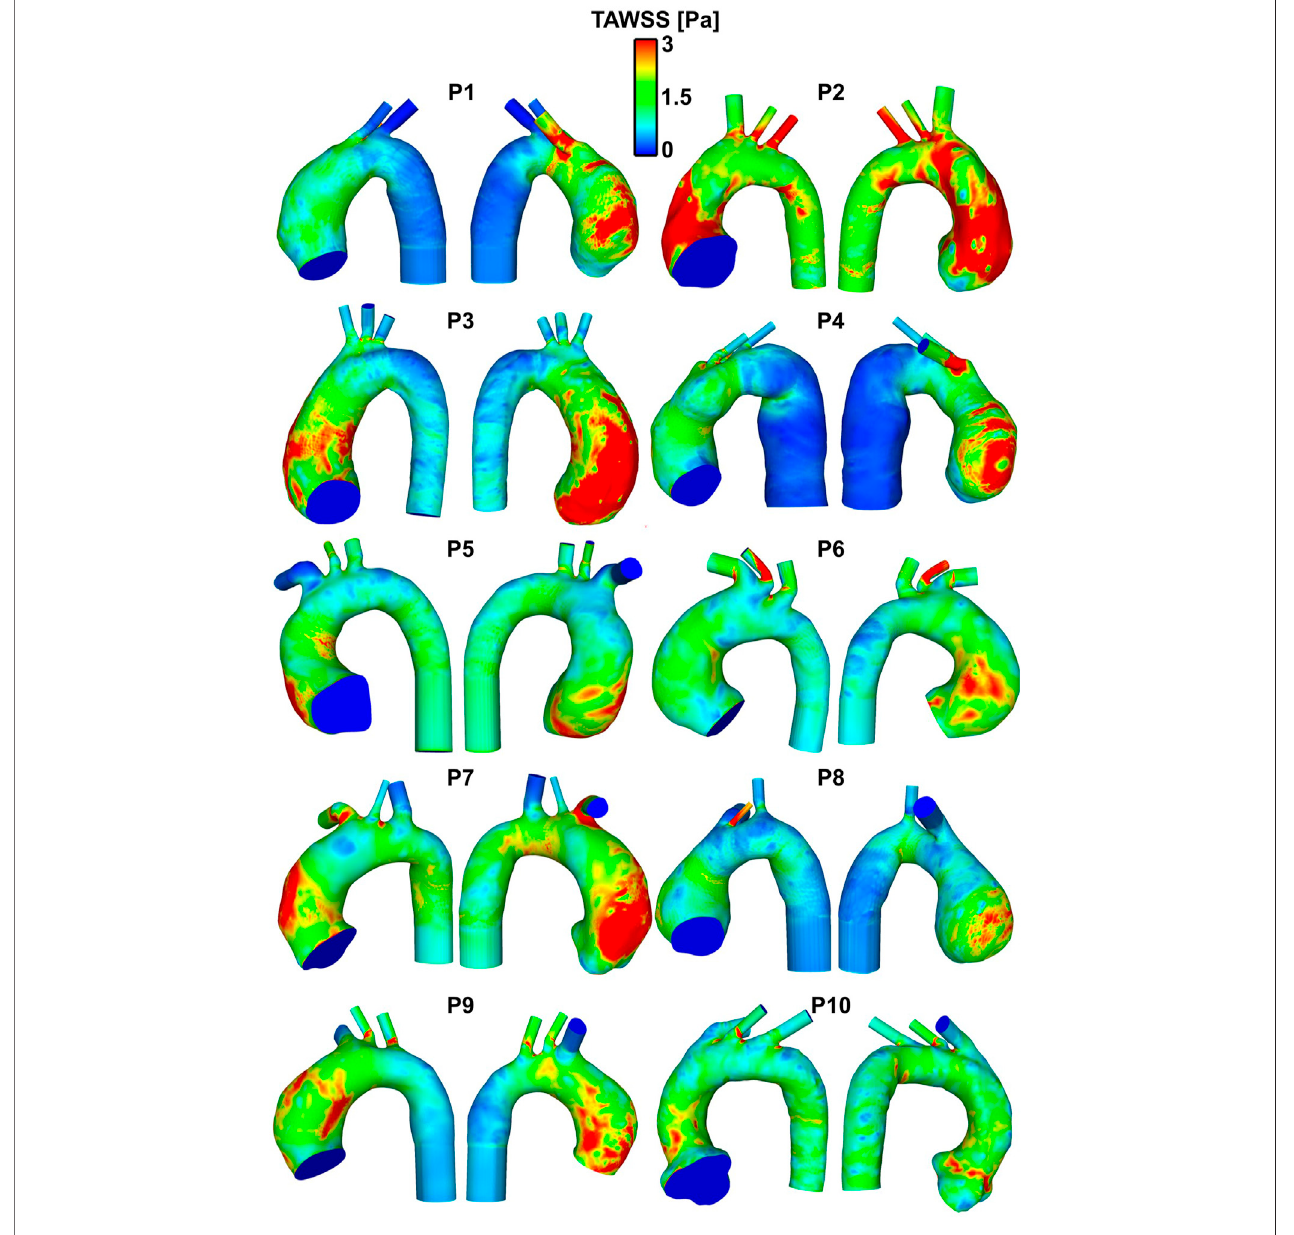
FIGURE 4 | Patient-speci fi c TAWSS distribution maps in the ten patients with ATAA. Regions in red indicate TAWSS > 3 Pa, which, on gross inspection, are localized to the aneurysmal aorta, and particularly to the outer curve.